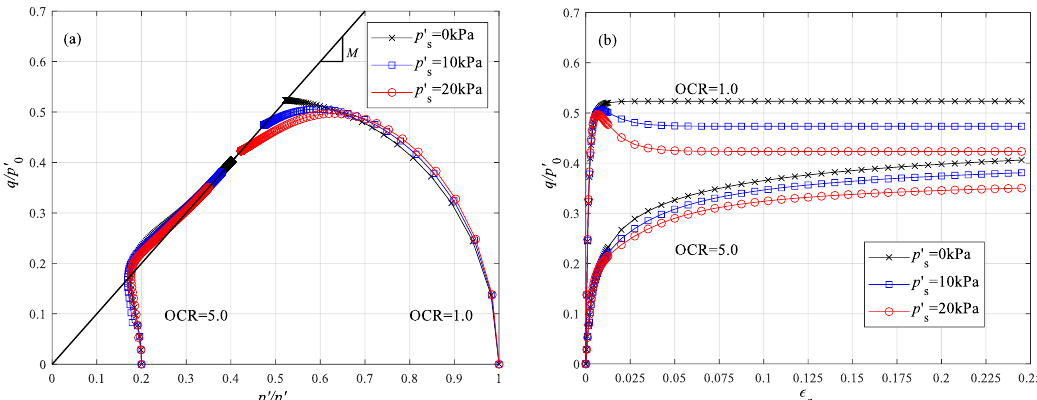
p  on ( a ) stress paths and ( b ) stress-strain s on ( a ) stress paths and ( b ) stress-strain relation-